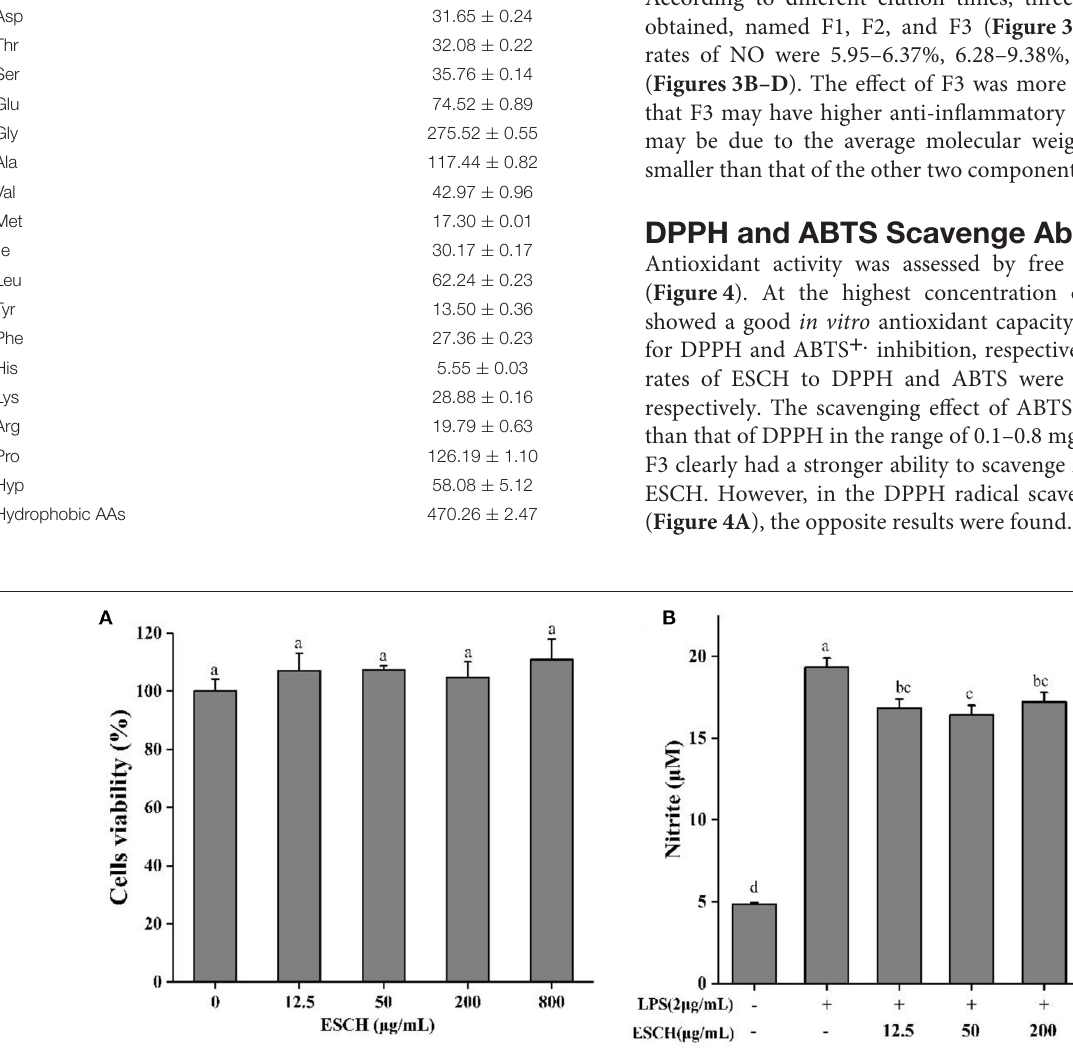
FIGURE 2 | Cell viability (A) and NO release (B) of ESCH in RAW264.7 macrophage. The results were expressed as means ± SD ( n = 3), where lowercase letters indicate significantly different at p < 0.05.